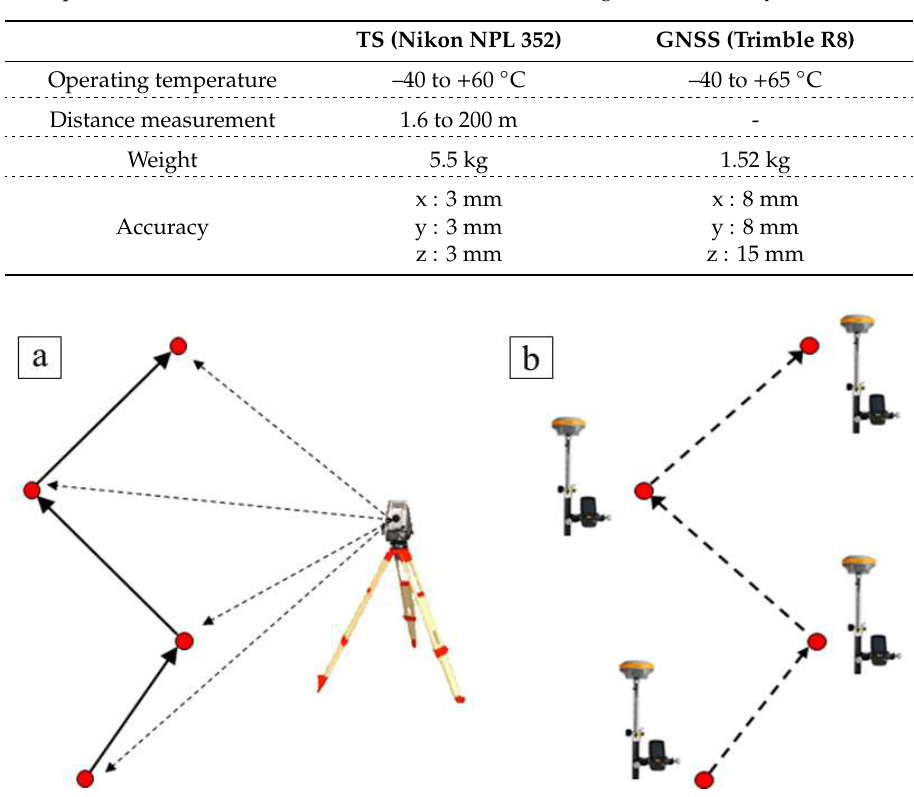
Table 3. Specifications of Total Station (TS) [28] and Global Navigation Satellite System (GNSS) [27].